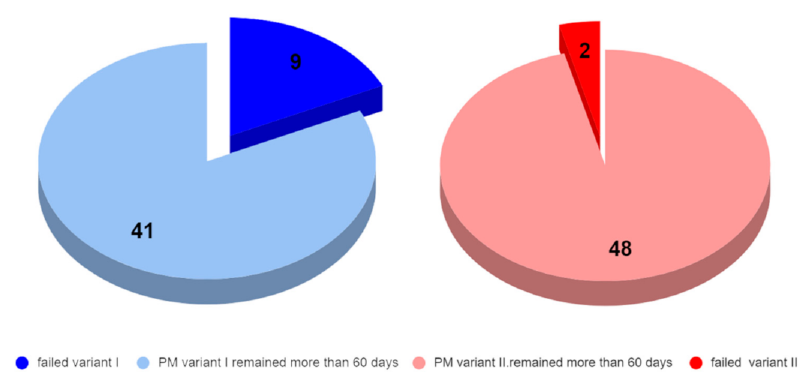
Figure 19. Visual chart of number of failed power-arms from all applied power-arms of that design (variant I on the left, variant II on the